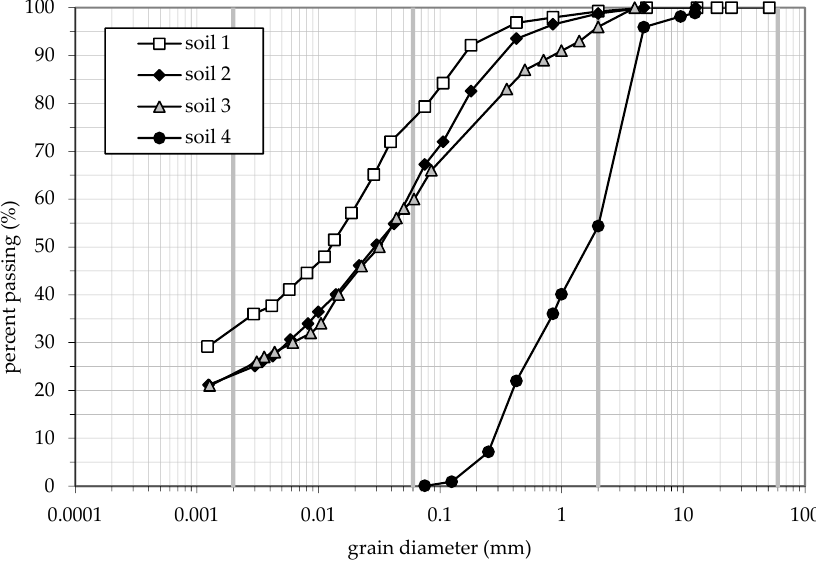
Figure 6. Grain size distribution of the soils used in the laboratory experiments.